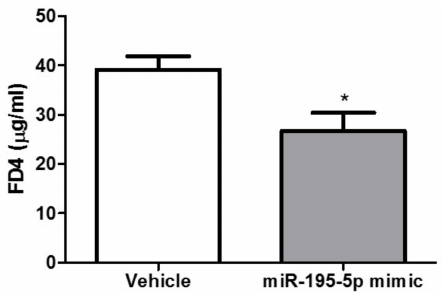
Figure 7. miR-195-5p mimic treatment reduces the in vivo intestinal permeability in DSS-induced colitis. In vivo permeability for FITC-dextran in two independent groups of vehicle and treated mice (n = 5 mice/group). * p <